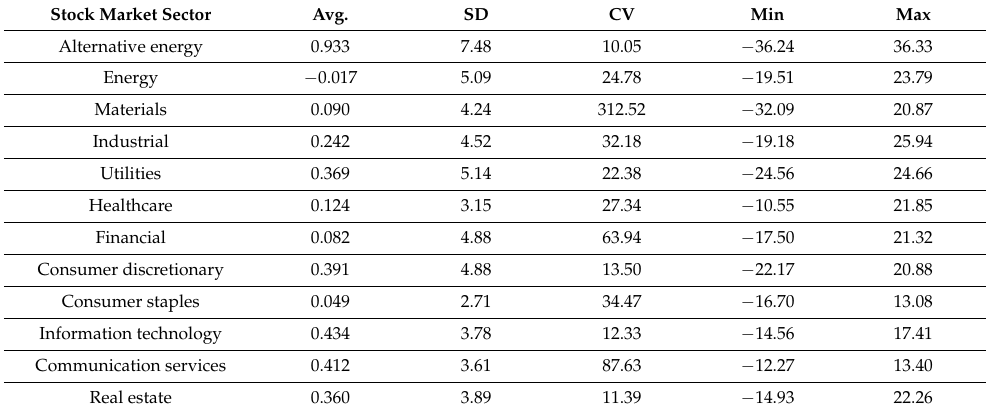
Table 2. Descriptive statistics for average weekly rates of return of alternative energy and main stock market sectors: based on the performance of the top give companies in January 2020–September